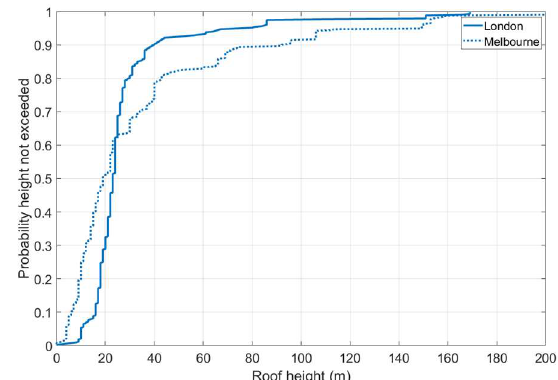
Figure 2. CDFs of the building distance (Db1 and Db12) for London and Melbourne, extracted from [11].